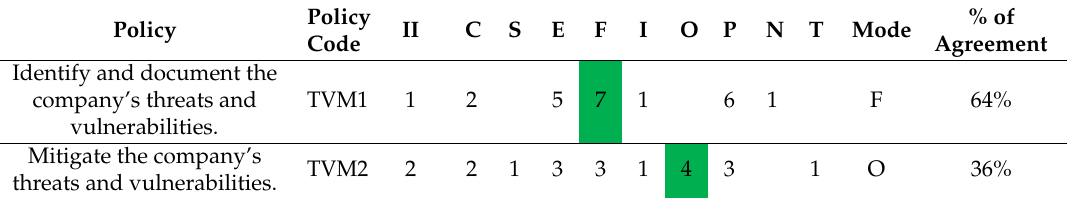
Table 12. Threat and vulnerability management policies’ progression